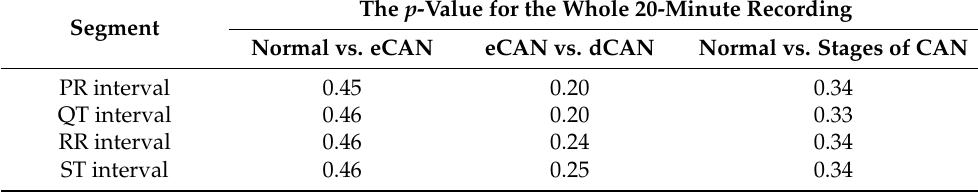
Table 3. p -value from the Kruskal–Wallis test for the whole 20